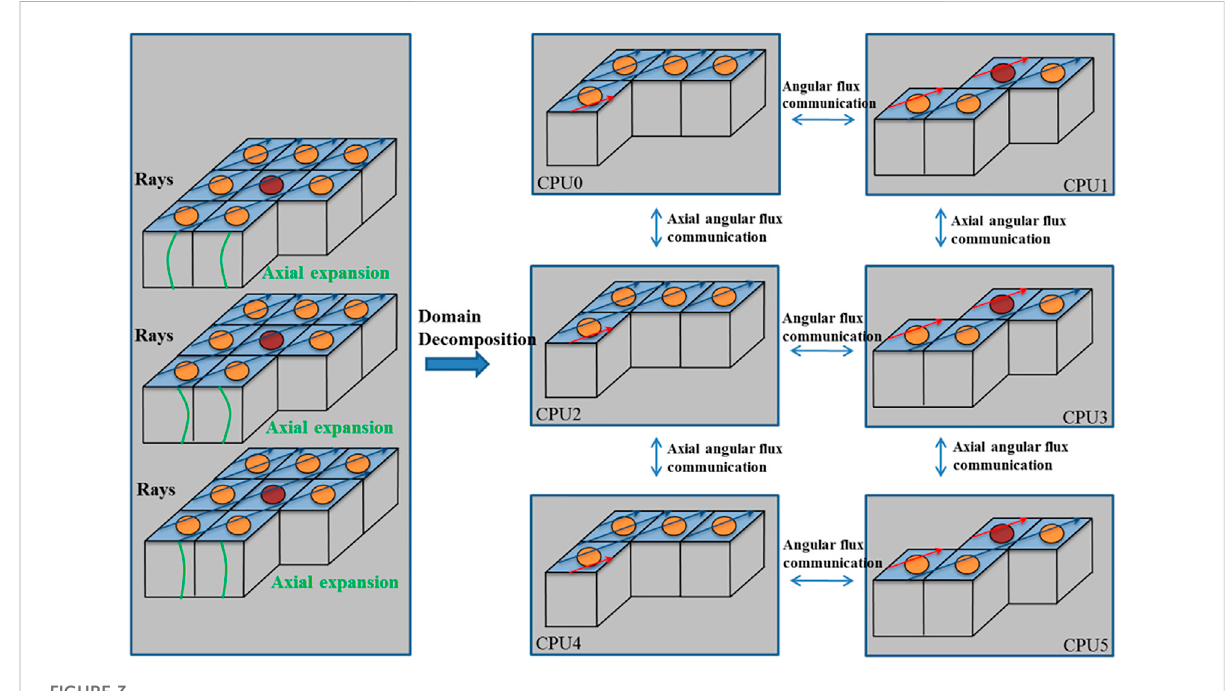
FIGURE 3 Domain decomposition parallel strategy in SHARK